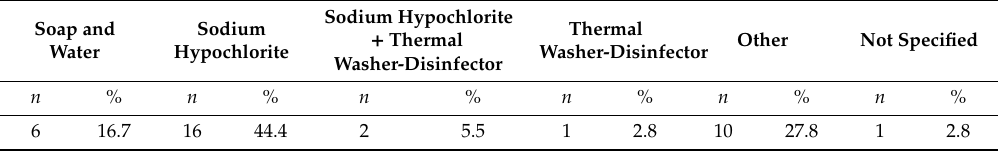
Table 3. Disinfection methods of the independent water bottle reservoirs in 36 dental o ffi ces equipped among 153 studied in Eastern France in